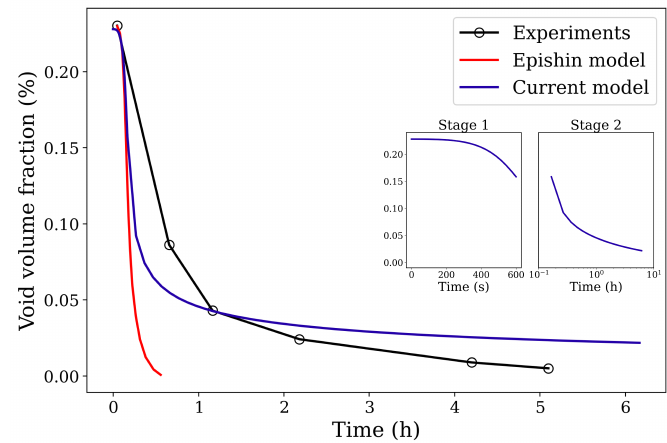
Figure 3. Comparison of void volume fraction evolution curves between experimental and simulation results. The experimental curve is obtained from Epishin et al. [21]. The figure inset indicates the two stages of HIP